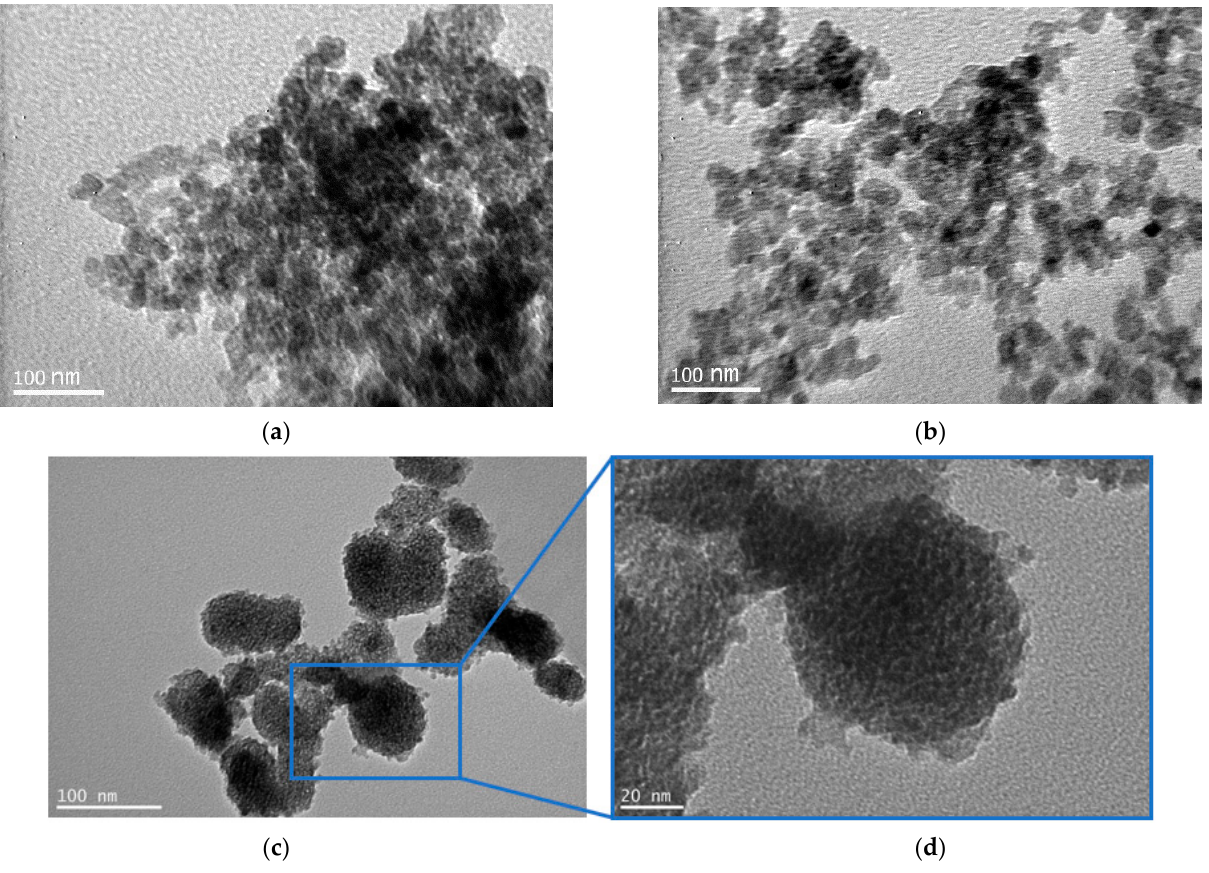
shape is typical for anatase crystallite structure [10].